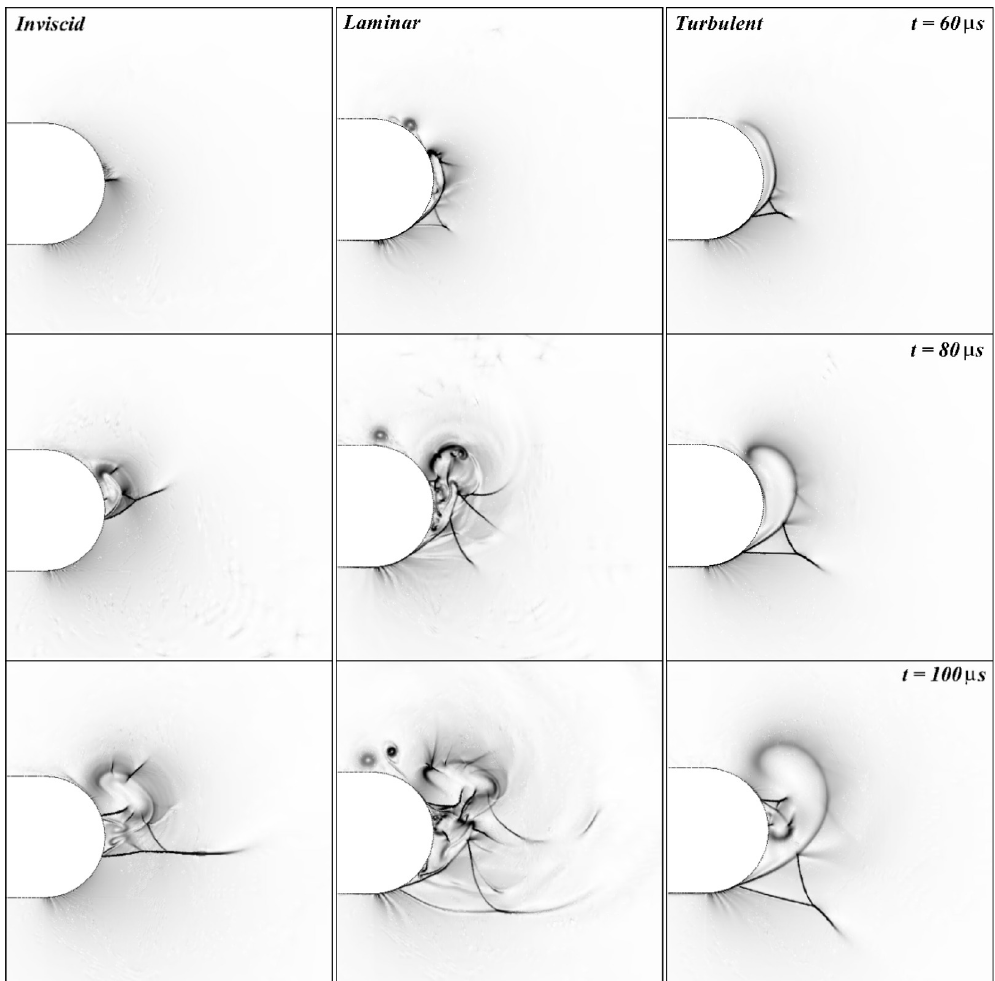
Fig. 8. Schlieren sequences of shock wave diffraction around curved splitter for different solvers.